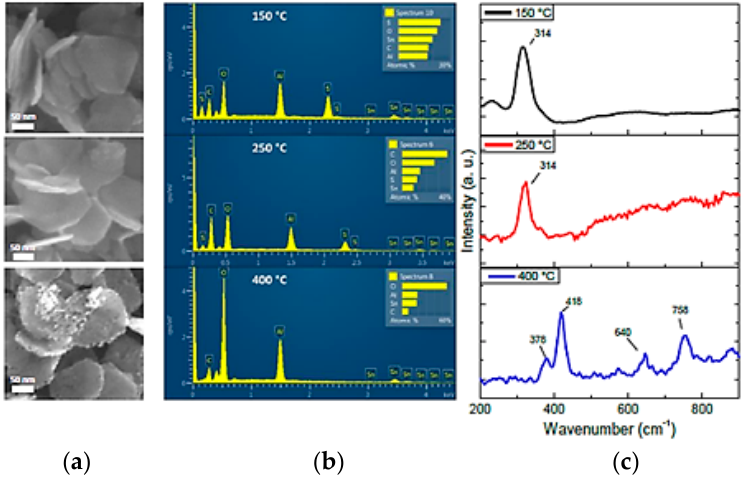
Figure 1. Effect of annealing temperature on the morphology and microstructure of 2D SnS 2 film. ( a ) SEM; ( b ) EDX analysis; ( c ) Micro-Raman spectroscopy.